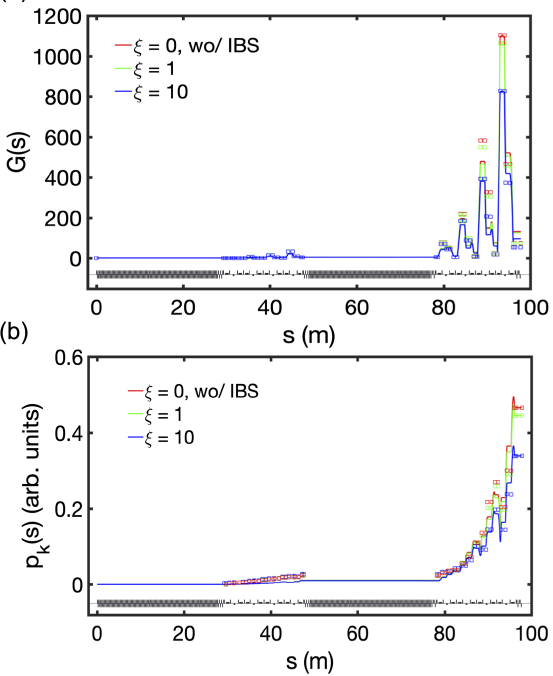
FIG. 7. (a) Gain functions G ð s Þ , Eqs. (70) and (84), as a function of s , for λ ¼ 125 μ m. (b) Energy modulation, Eq. (56), as a function of s , for λ ¼ 125 μ m. Only the steady-state CSR is included in the cases. The red with ξ ¼ 0 corresponds to the case without IBS; the green ξ ¼ 1 includes the normal IBS effect; the blue ξ ¼ 10 means the enhanced IBS inflation effect [see Eq. (70)]. In ELEGANT simulations, marked as square symbols, the initial modulation amplitude is set 0.01% and a total of 128-million macroparticles are used. Here we comment that, for the case with CSR and IBS, the tracking simulations may take about 10 hours using a 24-core computer, while obtaining the solid lines only takes within 5 minutes.